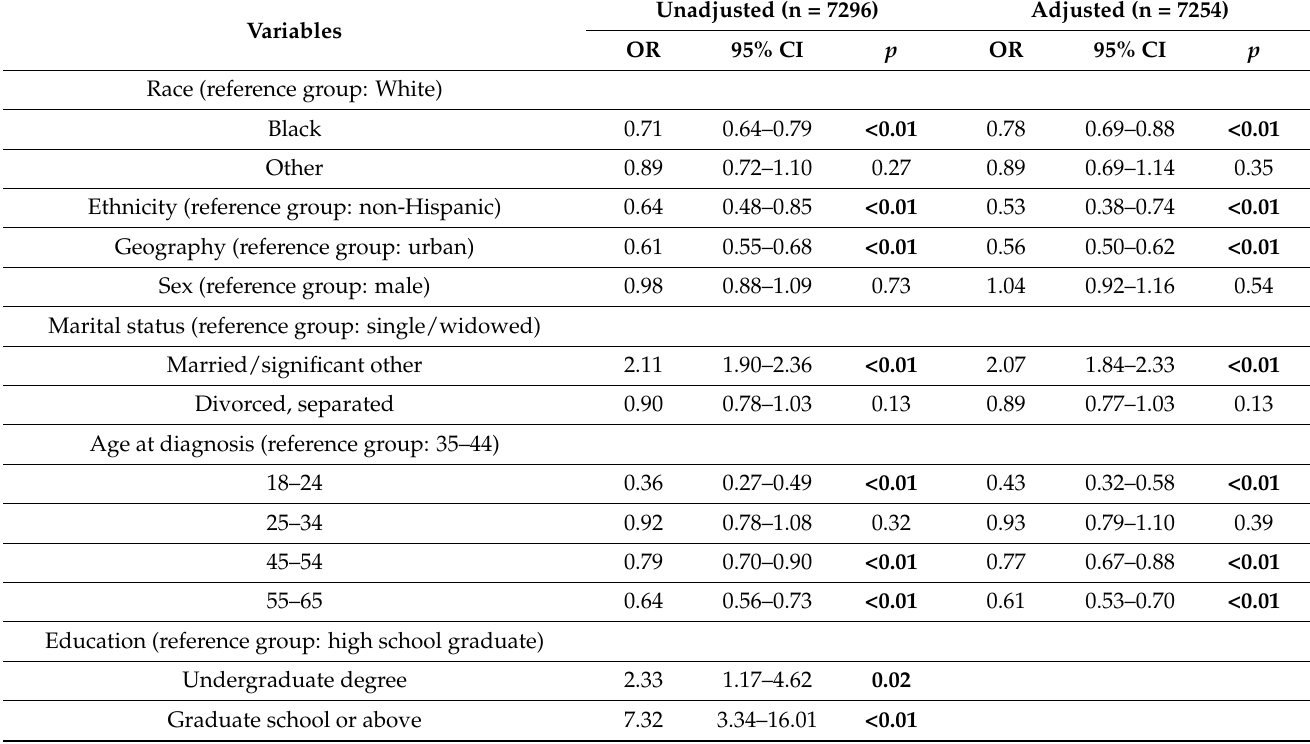
Table 2. Odds ratios and 95% confidence intervals from logistic regression analyses for variables associated with employment in cancer